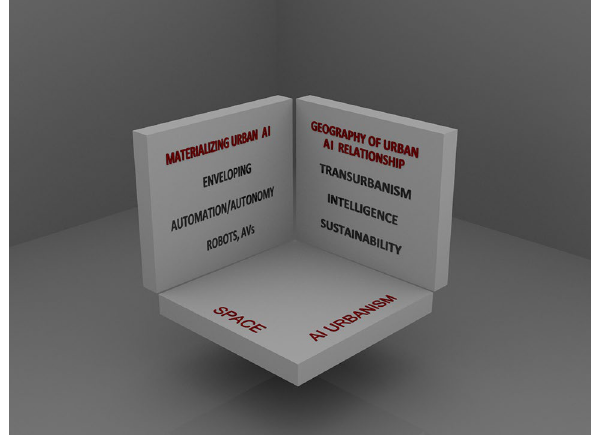
Fig. 2 Spatial coordinate: Implications of the mate- rialization of urban AI and effects on urban